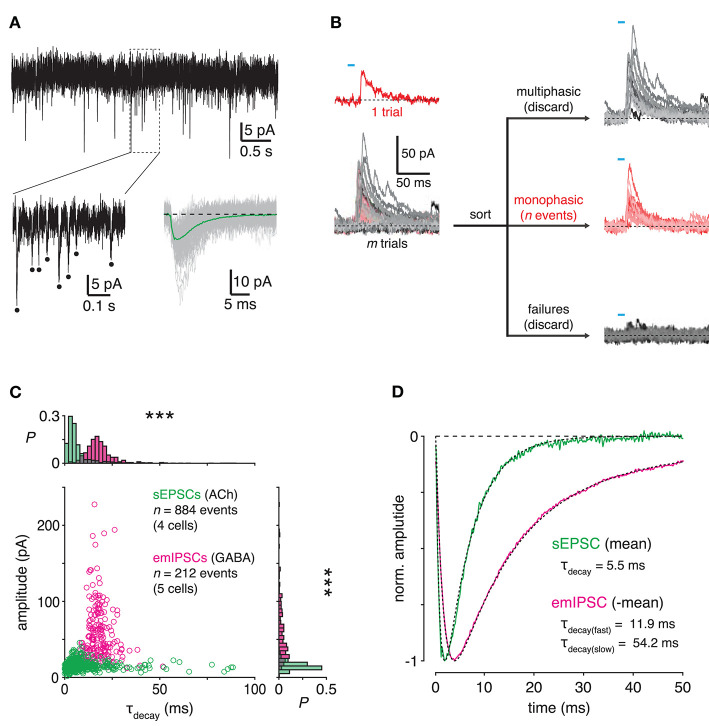
Transmitter-specific postsynaptic filtering in SAC→DSGC transmission. (A) Isolation and measurement of spontaneous cholinergic EPSCs in ON-OFF DSGCs. Top, spontaneous EPSCs (sEPSCs) recorded from an ON-OFF DSGC during blockade of AMPA (50 μM DNQX) and NMDA (50 μM D-AP5) receptors. Bottom left, expanded view of boxed region. Dots indicate individual spontaneous EPSCs. Bottom right, alignment and averaging of cholinergic sEPSCs. One hundred individual sEPSCs (light gray) superimposed with the mean (green) of all sEPSCs. Dotted line indicates baseline holding current. (B) Schematic diagram illustrating experimental generation and recording of evoked monophasic IPSCs (emIPSCs) in an ON-OFF DSGC. Brief (<10 ms) optogenetic stimulation of presynaptic SACs evokes a small, monophasic IPSC (red). Following m trials, n monophasic events are distinguished from multiphasic events and failures. (C) Comparison of all sIPSCs and emIPSCs recorded in DSGCs. Amplitude is plotted against decay time constant (τdecay) for all sIPSCs (n = 884 events in 4 ON-OFF DSGCs) and emIPSCs (n = 212 events from 4 ON-OFF DSGCs and 1 ON DSGC). Marginal probability distributions of amplitude and τdecay are shown at right and above, respectively. PSC amplitude—sEPSC vs. emIPSC: ***p < 0.001, D = 0.82 (Kolmogorov-Smirnov test). (D) Averaged time courses of sIPSCs and emIPSCs. The average of all sIPSCs (green) is fit (black, dashed; see Materials and Methods) with a single exponential decay term. The average of all emIPSCs (inverted, magenta) is fit with two exponential decay terms. Traces are normalized to their respective maxima.